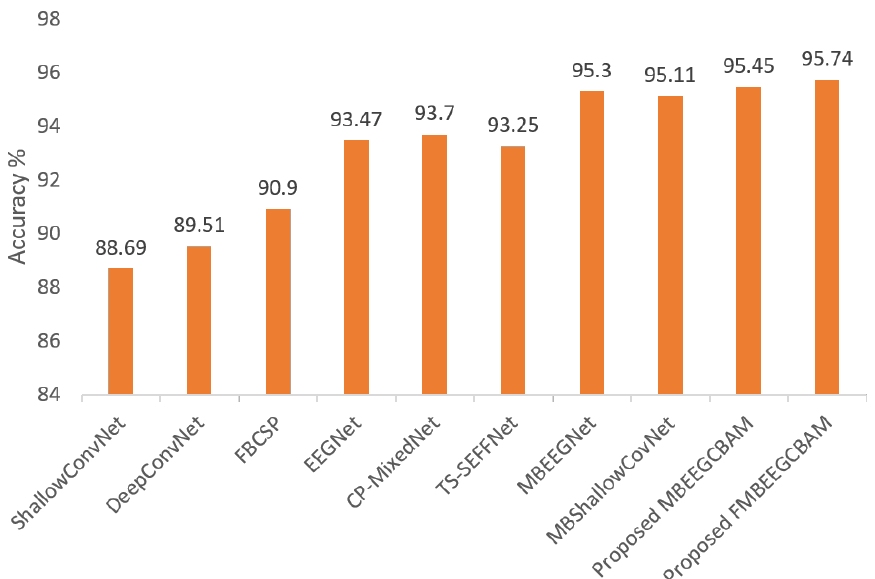
Figure 8. Average classification accuracy on the HGD. The methods compared are ShallowConvNet [18] , DeepConvNet [18] , FBCSP [25] , EEGNet [27] , CP-MixedNet [34] , TS-SEFFNet [37] , MBEEGNet [40] ,